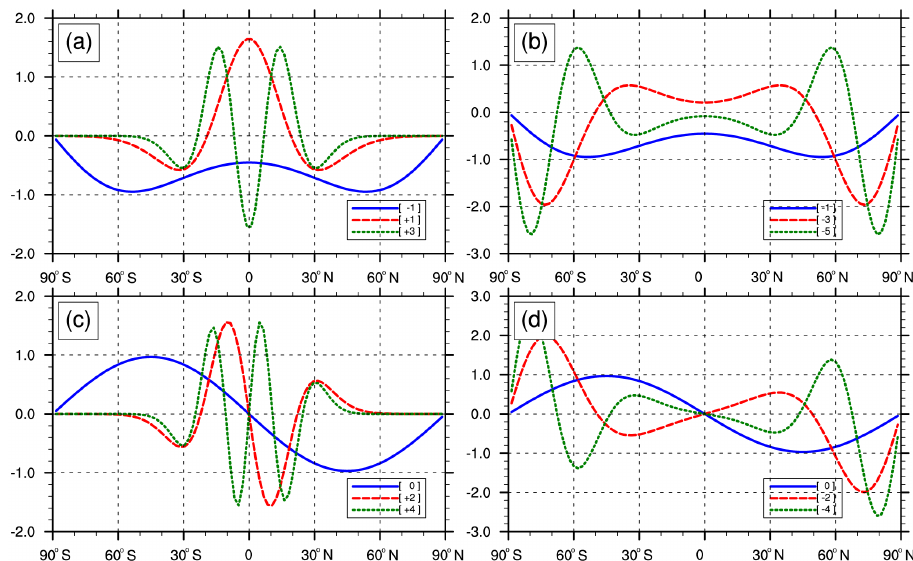
Figure 1. The first few symmetric and anti-symmetric Hough modes for DW1 ( s = 1, σ = 0 . 5) of scalar fields, computed using the normal- ized associated Legendre polynomial (ALP) expansions. Panels (a, b) are for symmetric modes; (c, d) are for anti-symmetric modes. The labels are [ − 1] for the first negative mode with largest negative eigenvalue, [ + 1] for the first positive mode with largest positive eigenvalue, and [0] for the so-called missing mode with zero eigenvalue or infinite equivalent